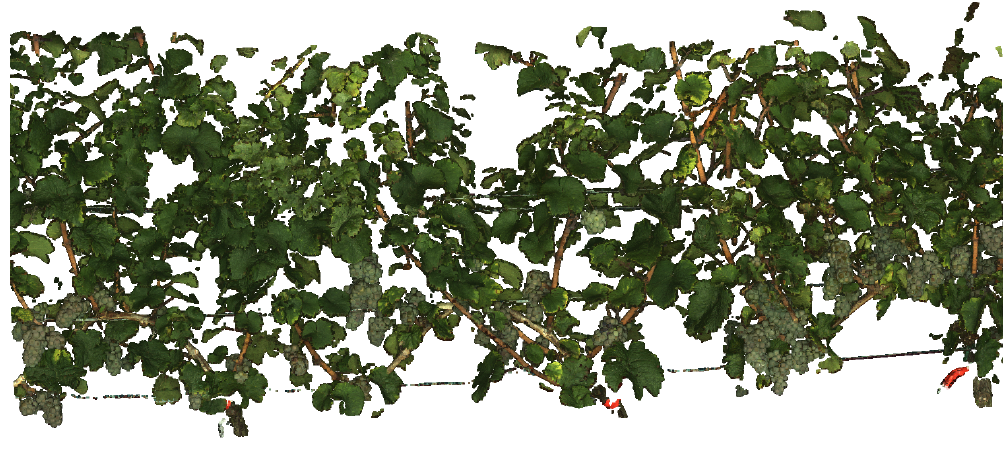
Figure 8. Original VSP trellis point